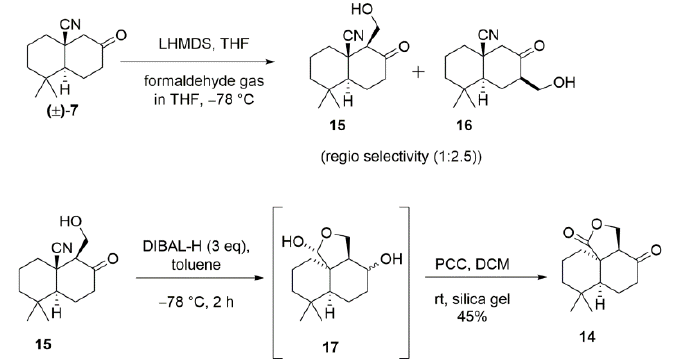
Scheme 6. Regioselectivity of compound 7 (a controlled